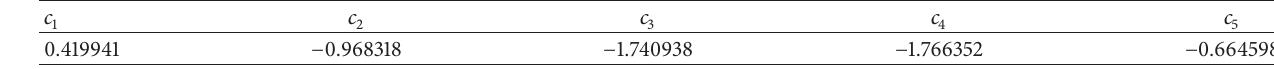
Table 2: The resultant coefficients polynomial values.